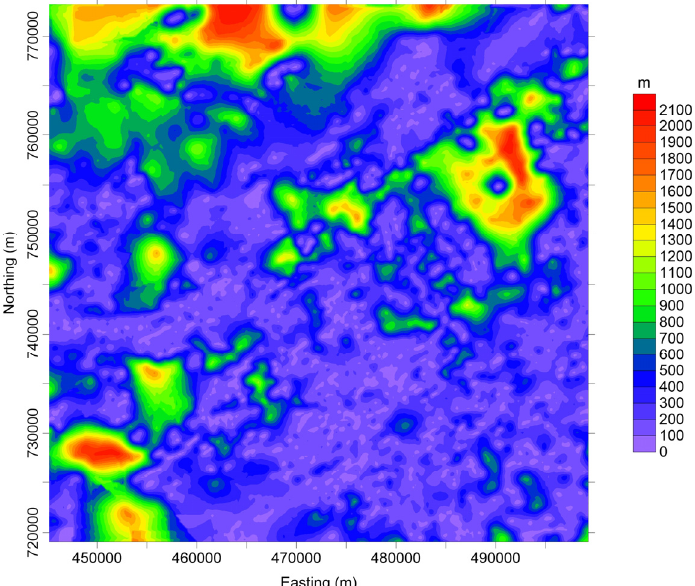
Figure 7. TDT map of the study area.